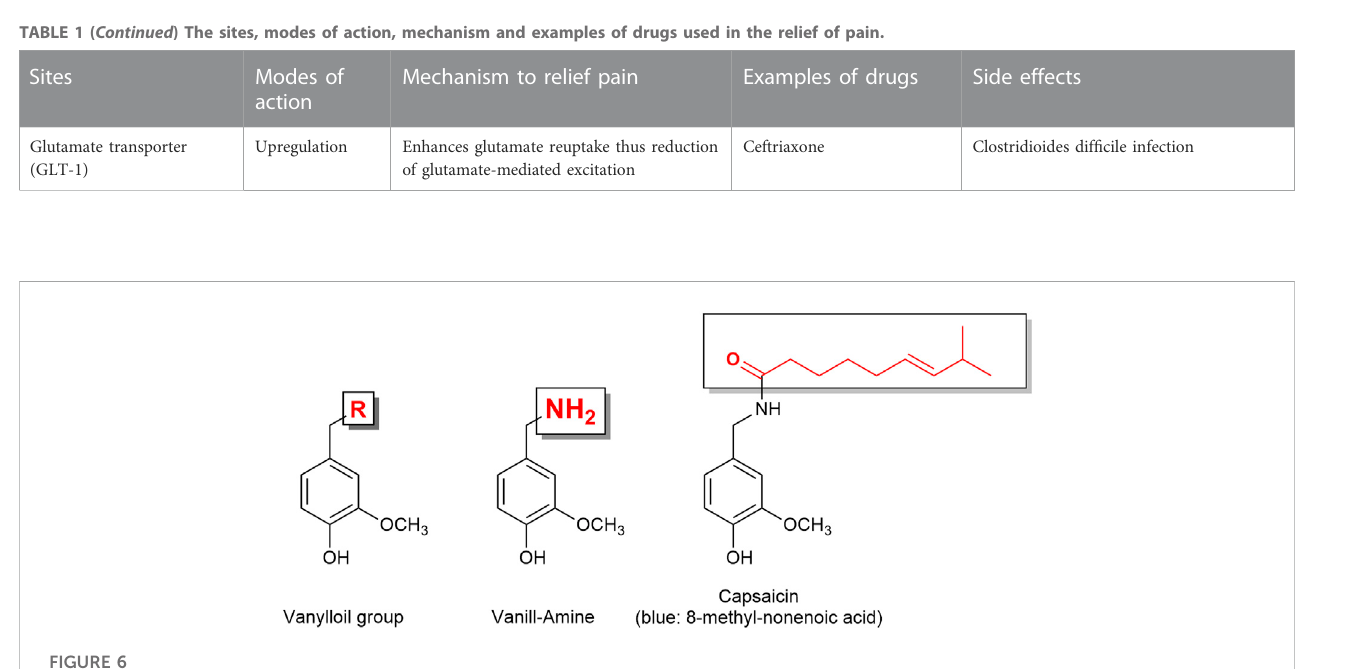
FIGURE 6 Capsaicin is a vanilloid derivative. The capsaicin receptor was therefore named vanilloid